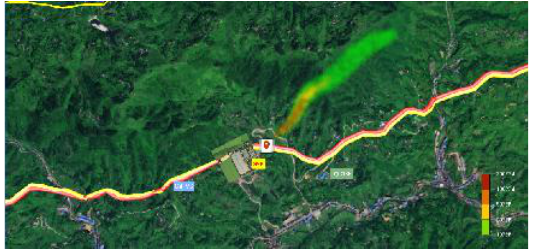
Figure 7. 2D gas dispersion animation on WebGIS